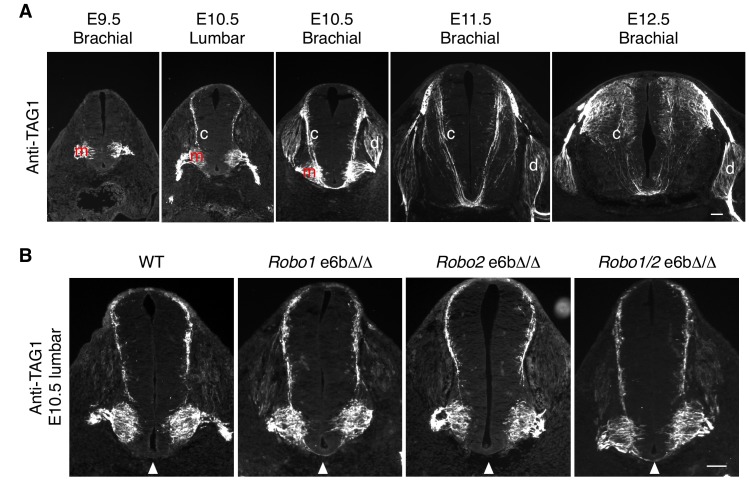
Developmental expression of TAG1 in mouse embryos.(A) TAG1 expression in motor (m), commissural (c), and dorsal root ganglion (d) neurons from E9.5 to E12.5 in mice. TAG1 expression in motor columns was first observed at E9.5. By E11.5, the expression was no longer seen on motor neuron cell bodies, and has been shown to become restricted to the axons until E14 (Dodd et al., 1988). TAG1 expression in commissural neurons started at E10.5 at the lumbar level and receded by E12.5. In DRG neurons, TAG1 expression initiated at E10.5 at the brachial level, and has been reported to disappear in most DRG populations during late embryonic stages (Dodd et al., 1988). (B) Anti-TAG1 staining of transverse sections of WT and Robo e6bΔ/Δ spinal cords at E10.5 lumbar level. Arrowheads indicate the ventral commissure. TAG1 expression and thus the developmental stage of the embryos were comparable between genotypes. Scale bars, 50 μm.